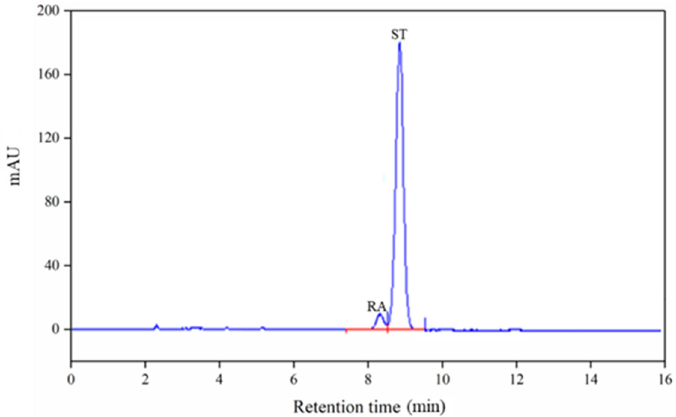
Figure 7. HPLC chromatogram of the solid phase after second crystallization at 210 nm wave- lengths.